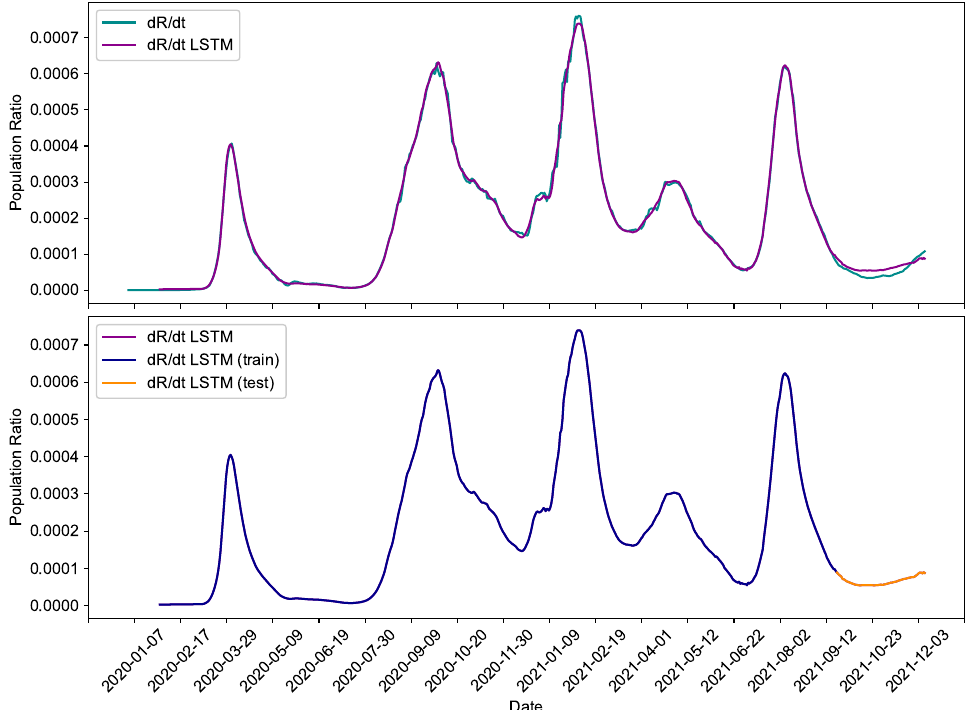
Figure 2. Output from the LSTM network for